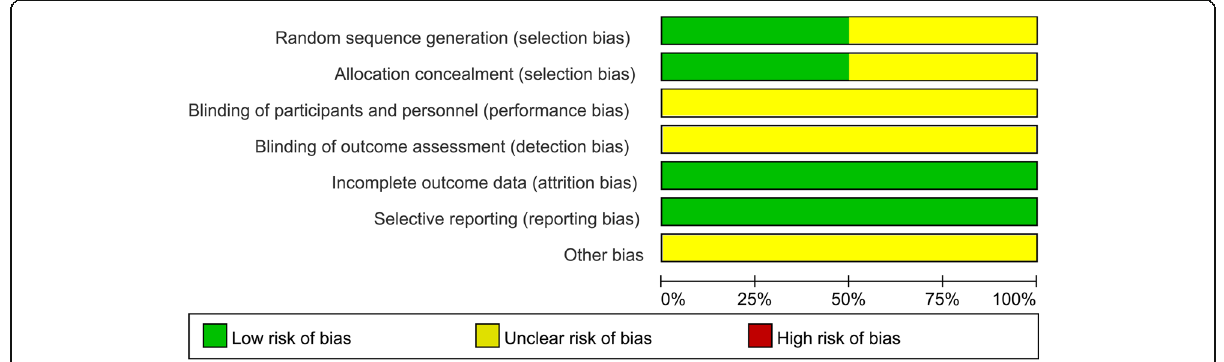
Fig. 2 Risk of bias graph: review authors ’ judgements about each risk of bias item presented as percentages across all included randomized controlled trials